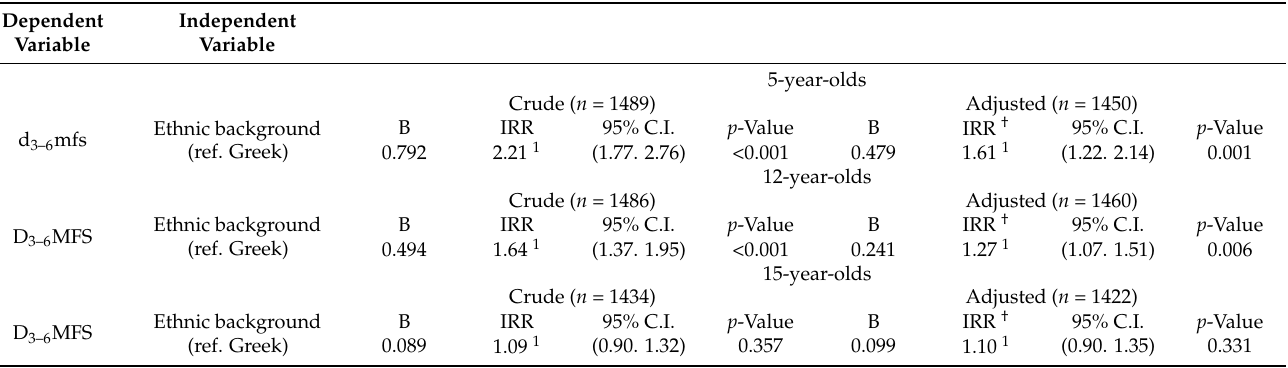
Table 6. Effect of ethnic background on the d 3–6 mfs/D 3–6 MFS of the total population of 5-, 12- and the 15-year-old children and adolescents (both of native Greek and of immigrant origin) that were examined (negative binomial regression